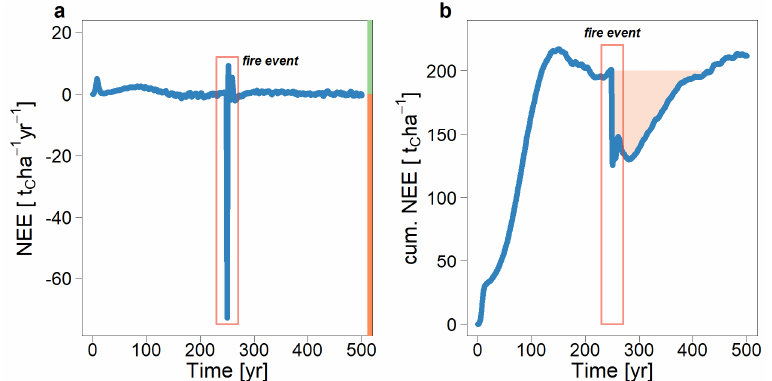
Figure 10. Simulated net ecosystem exchange after a fire event. Positive values correspond to net carbon sequestration in the forest. In the year 250, a large-scale fire was simulated, which led to a strong carbon source. ( a ) Annual carbon flux (NEE) and ( b ) cumulative carbon flux. The red area in ( b ) indicates the cumulative carbon flux before the forest fire.